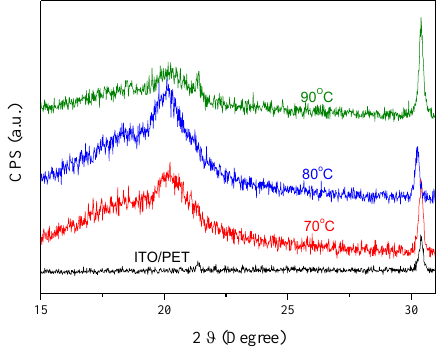
Figure 5. The FTIR analysis of 10 wt% PVDF film under different annealing